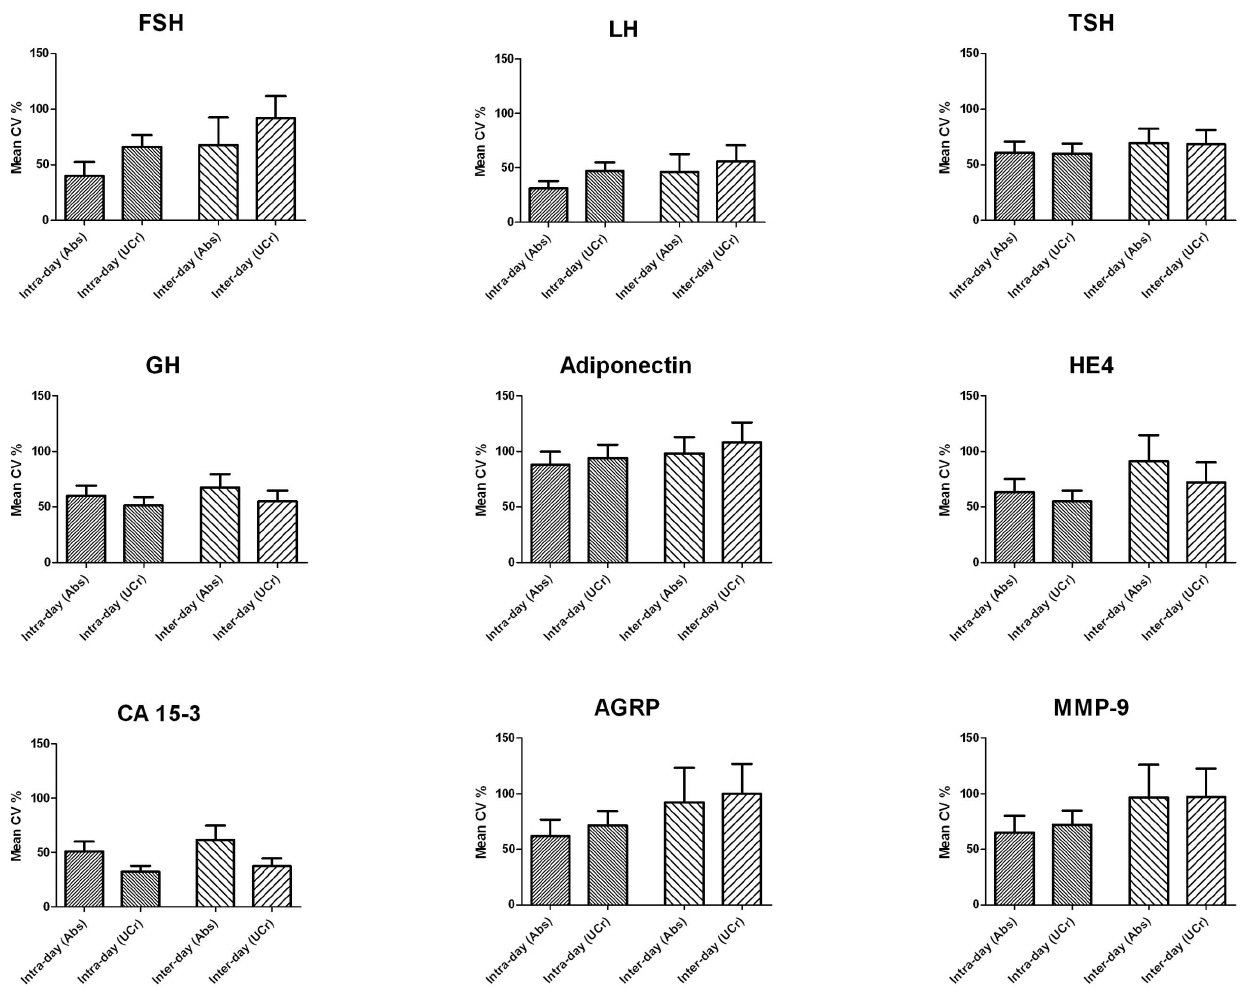
Figure 4. Temporal variability of urine biomarkers. Urines were collected three times a day (day, evening, night) over a two day period from 25 healthy female donors. Each urine sample was evaluated for 29 biomarkers by multiplexed immunoassay. Coefficients of variation (CV) were calculated for each biomarker among the three samples obtained each day (intra-day) and among the six samples obtained over the two day period (inter-day). Mean CVs for each reproducibly detectable biomarker in the entire 25 donor set are presented. Abs – absolute measurements; UCr – measurements normalized to levels of urine creatinine. Error bars represent 95% confidence intervals.